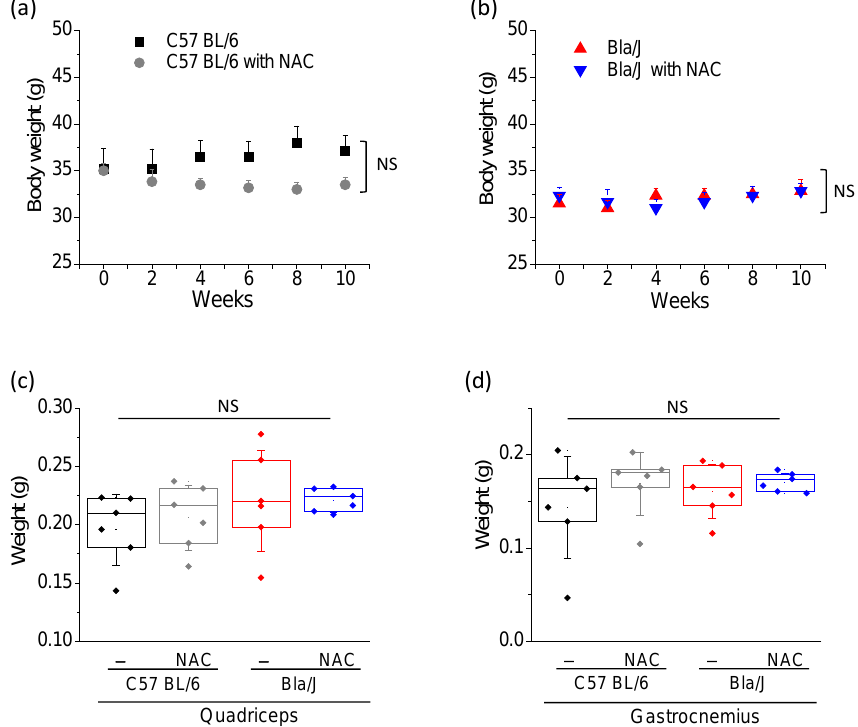
Figure 3. E ff ects of NAC on and body mass and muscle weights in C57 BL / 6 and dysferlin-deficient Bla / J mice. Body mass was controlled immediately prior to the onset of the treatment (week 0) and then every two weeks in C57 BL / 6 ( a ) and Bla / J mice ( b ). Quadriceps ( c ) and gastrocnemius ( d ) wet mass were evaluated after finishing NAC supplementation. In panel ( a , b ), data show mean ± SE of body weight. No significant (NS) di ff erences were found (paired ANOVA for repeated measures) between body weights of non-treated and NAC treated animals over the 10 weeks of treatment. In panels ( c , d ), boxes indicate 25–75 percentiles of muscle weights, lines within boxes indicate medians, and whiskers indicate SD. Each dot represents an individual datum (six mice per group). No significant (NS) di ff erences were found (one-way ANOVA followed by Tukey-Kramer multiple comparisons test). All data pass the Kolmogorov–Smirnov normality test.